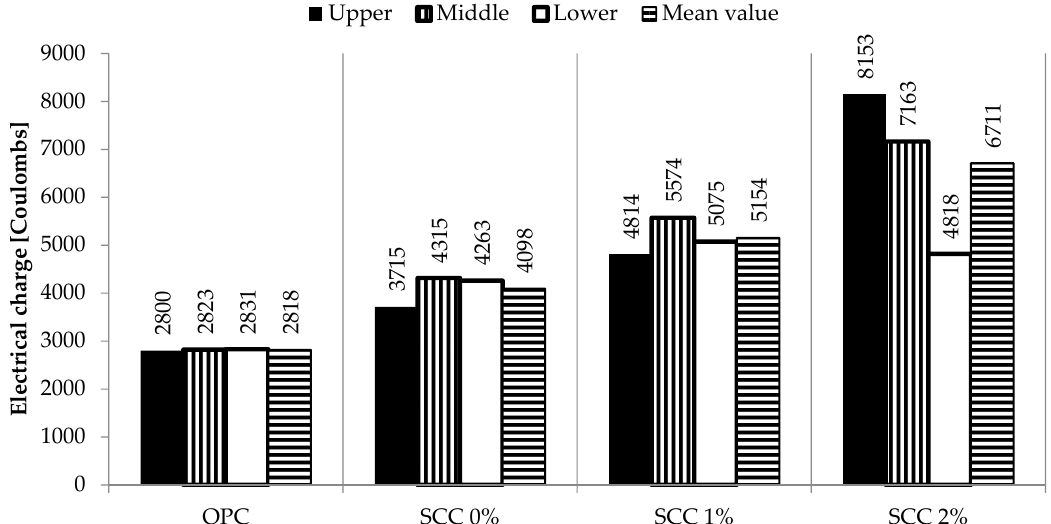
Figure 3. Results of the rapid chloride permeability test for three slices of testing and marked Upper, Middle and Lower, and mean values.